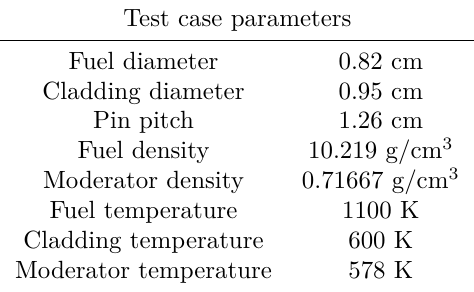
Table 1. Description of the material and geometry of the test